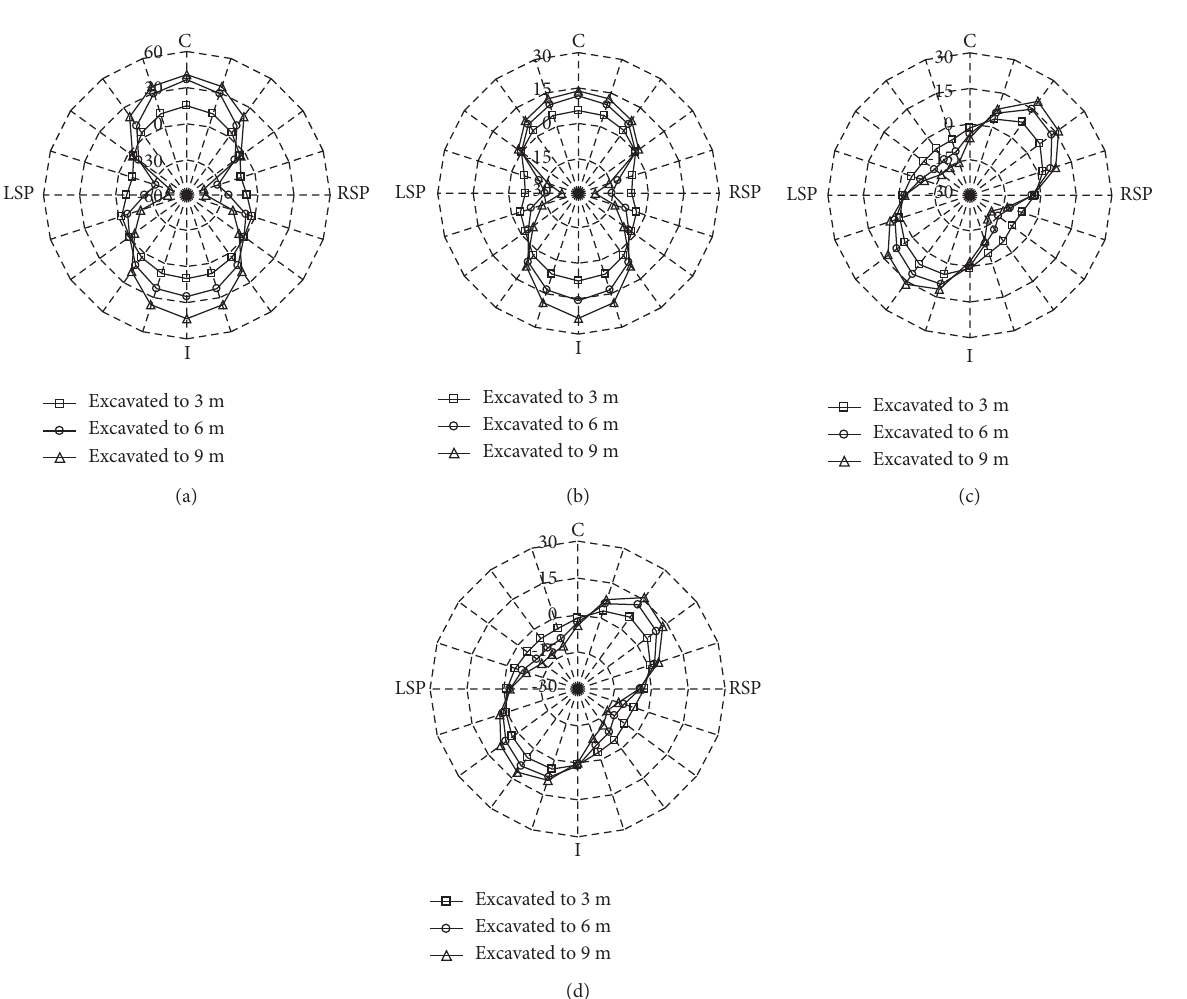
Figure 5: Additional tunnel bending moments (kN · m) for case C and case S. (a) Case C: C-C section, (b) case C: D-D section, (c) case S: C-C section, and (d) case S: D-D